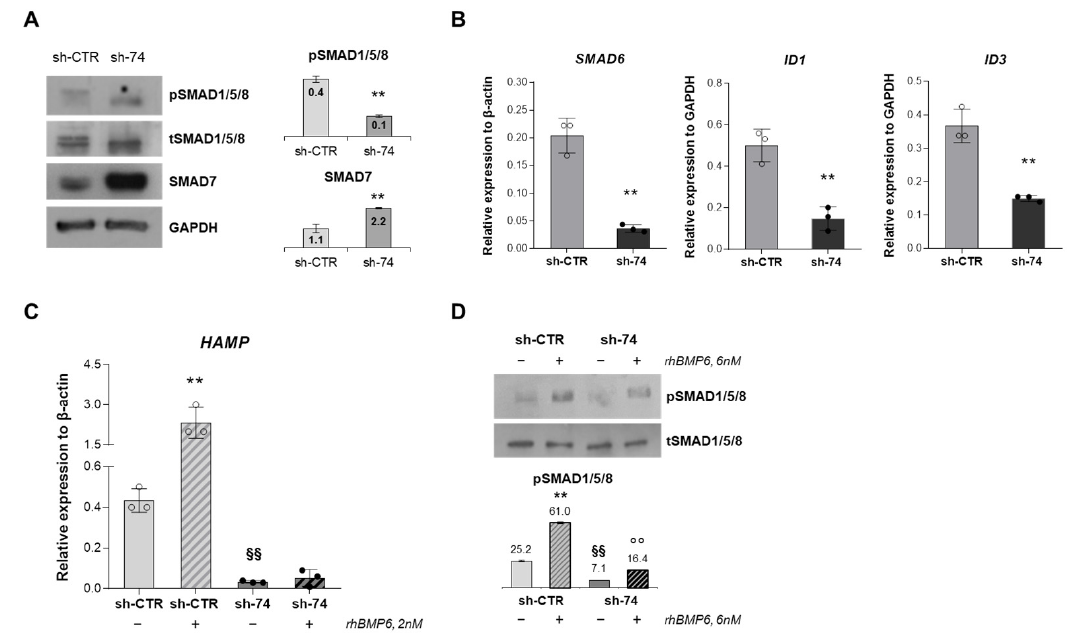
Figure 3. Evaluation of the activation of BMP/SMADs pathway in SEC23B-silenced HuH7 . ( A ) Left panel . Representative immunoblots of pSMAD1/5/8, tSMAD1/5/8 and SMAD7 proteins in total cells lysate of HuH7 sh-74 and sh-CTR cells. GAPDH is the loading control. Right panel . Quantification by densitometric analysis of three separate Western blots with similar results. Data are means ± standard deviation (** p < 0.01; Student’s t -test). ( B ) SMAD6 , ID1 , and ID3 gene expression in HuH7 sh-74 and sh-CTR cells. Data are means ± standard deviation of three independent experiments. (** p < 0.01; Student’s t -test). ( C ) HAMP gene expression in control HuH7 and sh74- SEC23B HuH7 cells treated or not with rhBMP6 (2 nM). Data are means ± standard deviation of three independent ex- periments. (** p < 0.01, sh-CTR + vehicle vs. sh-CTR + rhBMP6 (2 nM); ANOVA test and post-hoc correction by Tukey’s multiple comparison tests; §§ p < 0.01, sh-CTR vs. sh-74; Student’s t -test). ( D ) Representative immunoblots of pSMAD1/5/8 and tSMAD1/5/8 proteins in total lysate of HuH7 sh- 74 and sh-CTR cells treated (+) or not ( − ) with rhBMP6 (6nM). Densitometric analysis of three sepa- rate Western blots with similar results is shown (** p < 0.01, sh-CTR + vehicle vs. sh-CTR + rhBMP6 (6 nM); °° p < 0.01, sh-CTR + vehicle vs. sh-CTR + rhBMP6 (6 nM); §§ p < 0.01, sh-CTR vs. sh-74; Student’s t -test).